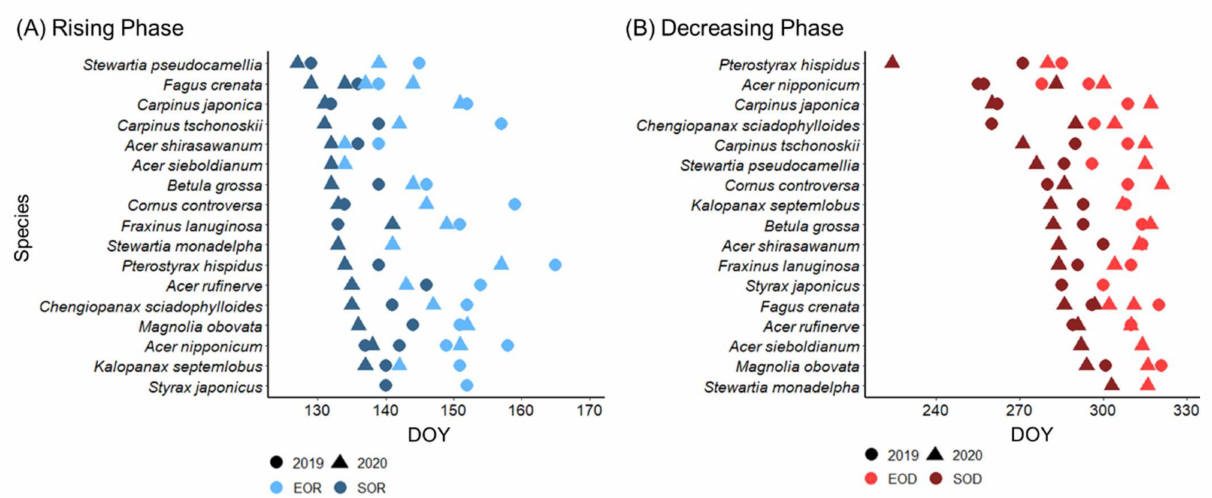
Figure 2. Inter-species variations in the phenological transition dates derived from crown leaf cover based on ground observations (CLC ground ) during the rising phase ( A ) and decreasing phase ( B ). Each data point represents the transition date of individual trees. The y -axis of each panel is sorted based on either SOR or SOD. Abbreviations: DOY, day of the year; SOR, start of the rising phase; EOR, end of the rising phase; SOD, start of the decreasing phase; EOD, end of the decreasing